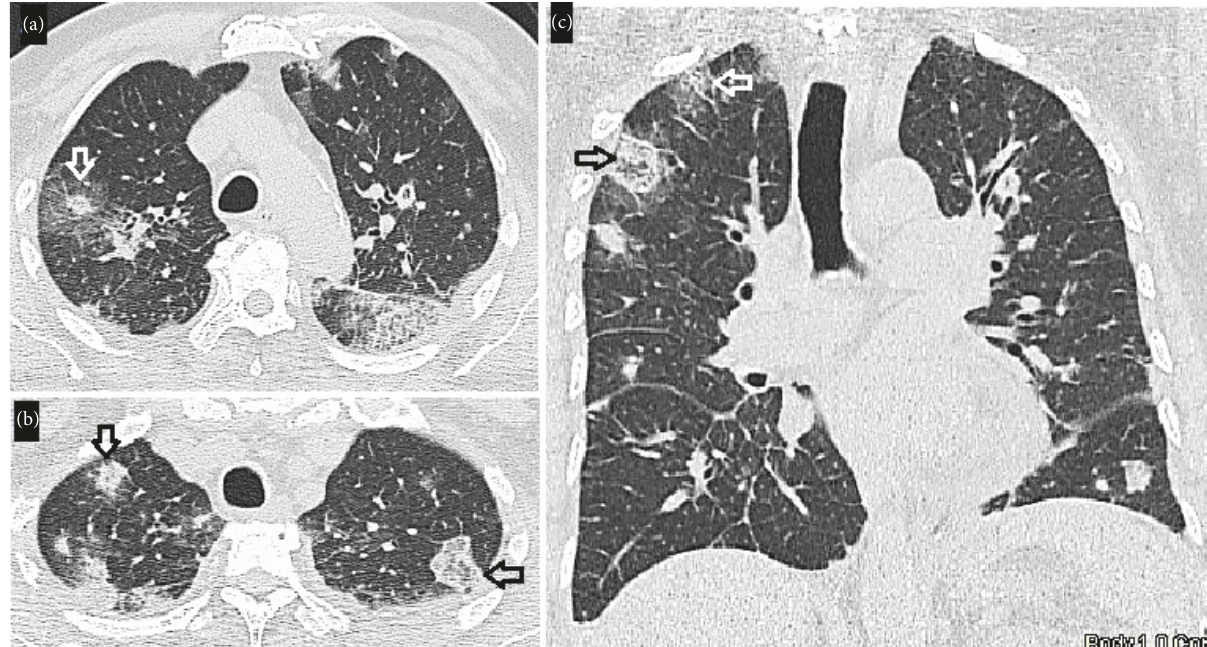
Figure 3: Chest CT scan. (a) Consolidations with peripheral ground-glass opacities compatible with halo sign in the apical segments of the upper lobes (white arrow). (b) Nodule with central ground-glass density and consolidation ring (reversed halo sign) in the apical segment of the upper lobes (black arrow). (c) Coronal reconstruction. Multiple peripheral nodules, some of them with reversed halo sign (black arrow) and halo sign (white arrow).